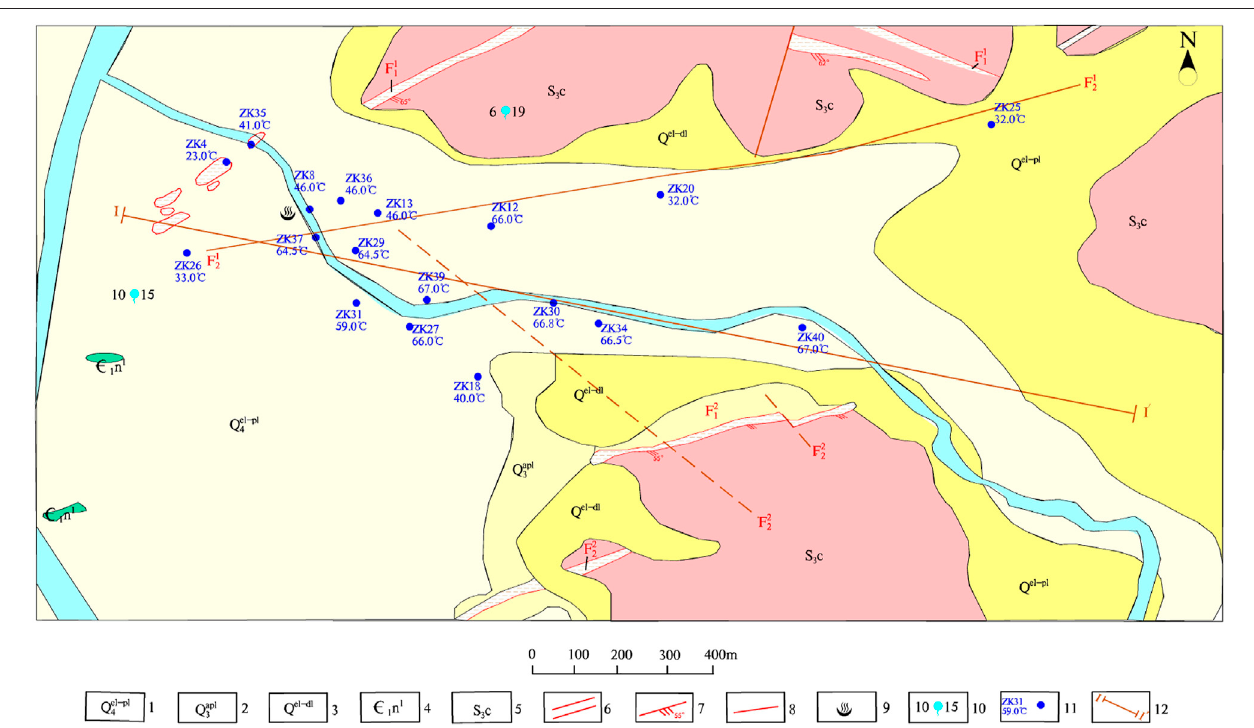
FIGURE 2 | Geological map of Wentang geothermal fi eld. 1 Quaternary Holocene fl ood alluvial layer. 2 Quaternary upper Pleistocene glacialdeposit. 3 Quaternary eluvial layer. 4 Lower Cambrian Niujiaohe Formation. 5 Late Silurian Chouping Unit. 6 Silici fi ed fracture zone. 7 Measured and speculated hidden compression-torsion fault. 8 Measured and speculated compression-torsion fault. 9 Hot spring. 10 Spring. 11 Borehole. 12 Cross section.